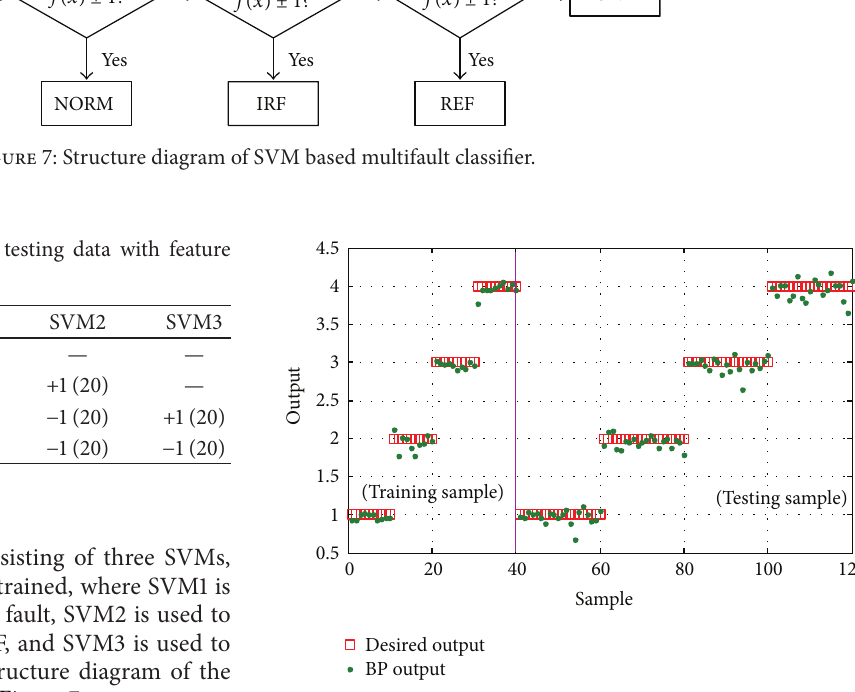
Figure 8: The BP classifier outputs of all samples with the same featurevectorasSVM-classifier.Thefirst40outputsaretrainingdata and the remaining 80 outputs are testing data.